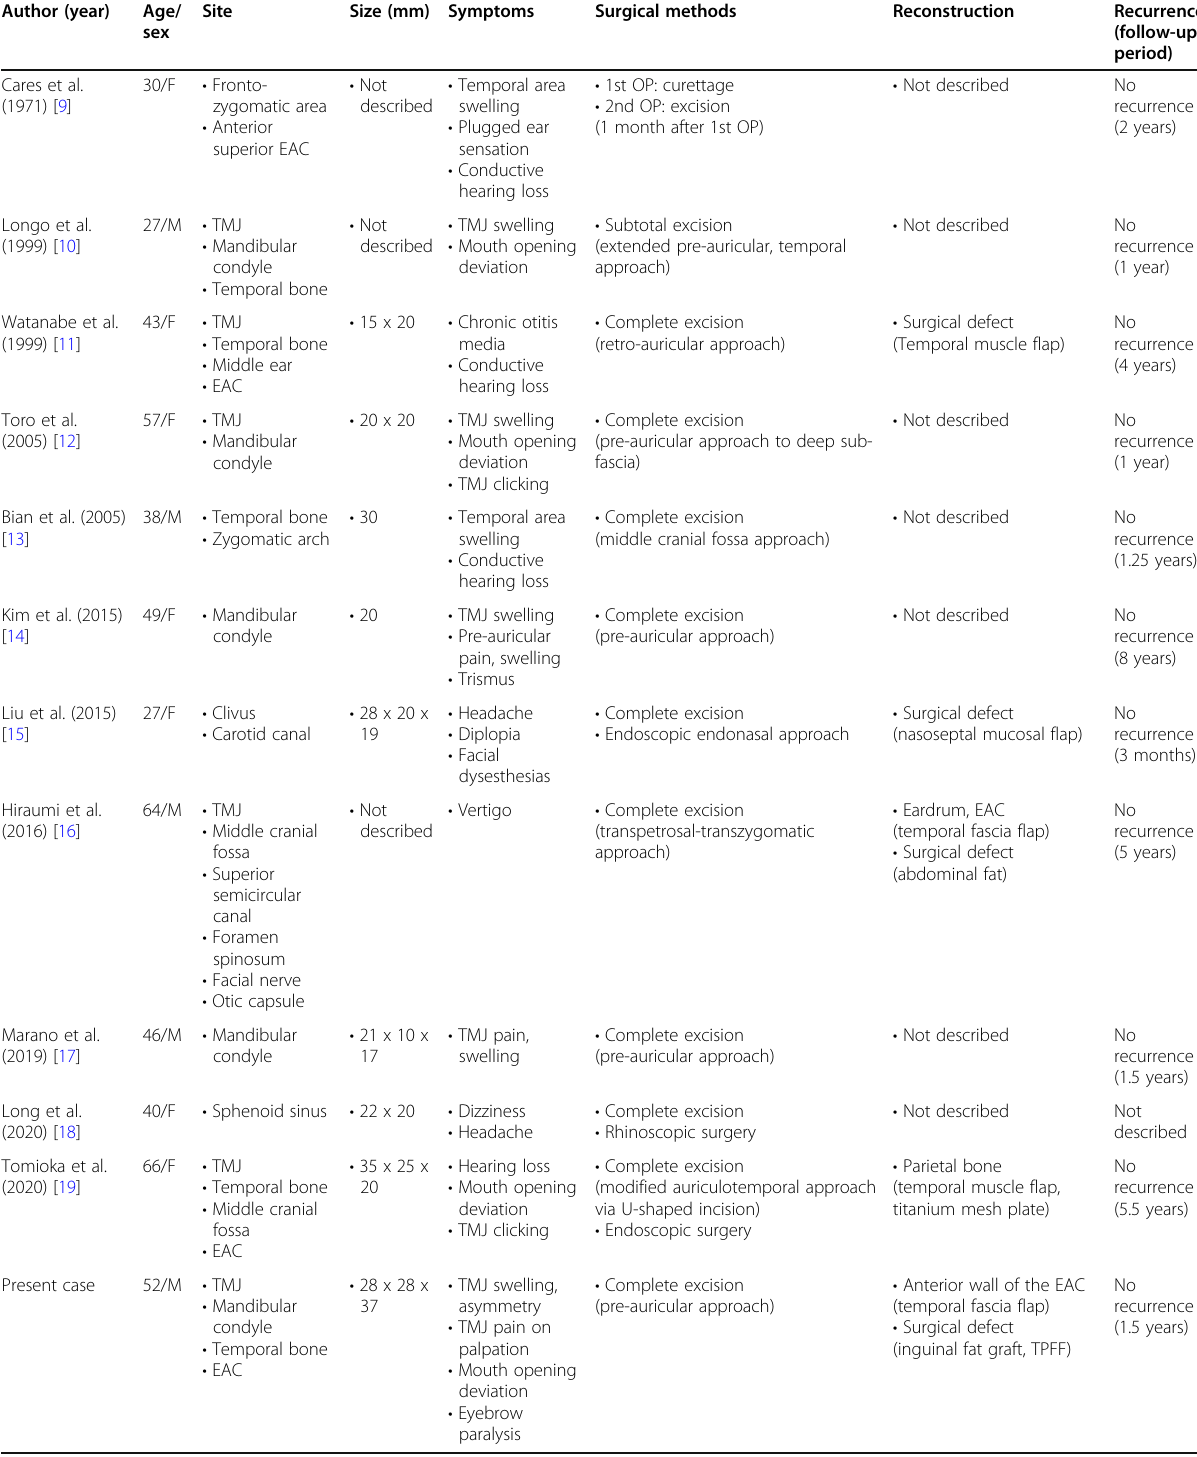
Table 1 Summary of characteristics for patients with craniofacial chondroblastomas (from 11